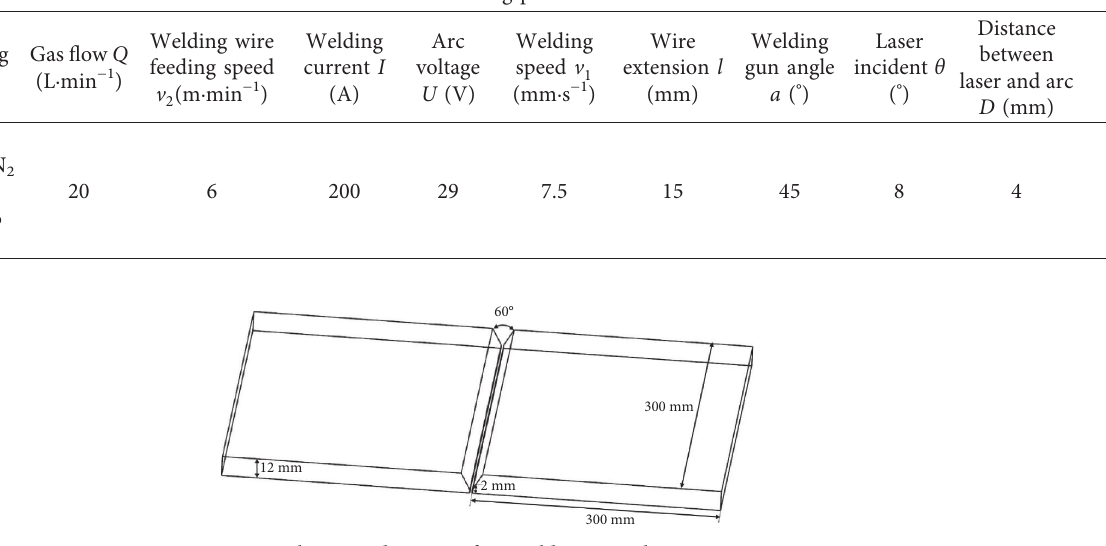
Figure 1: Schematic of hybrid laser-pulse MAG welding system. Table 2: Welding parameters.